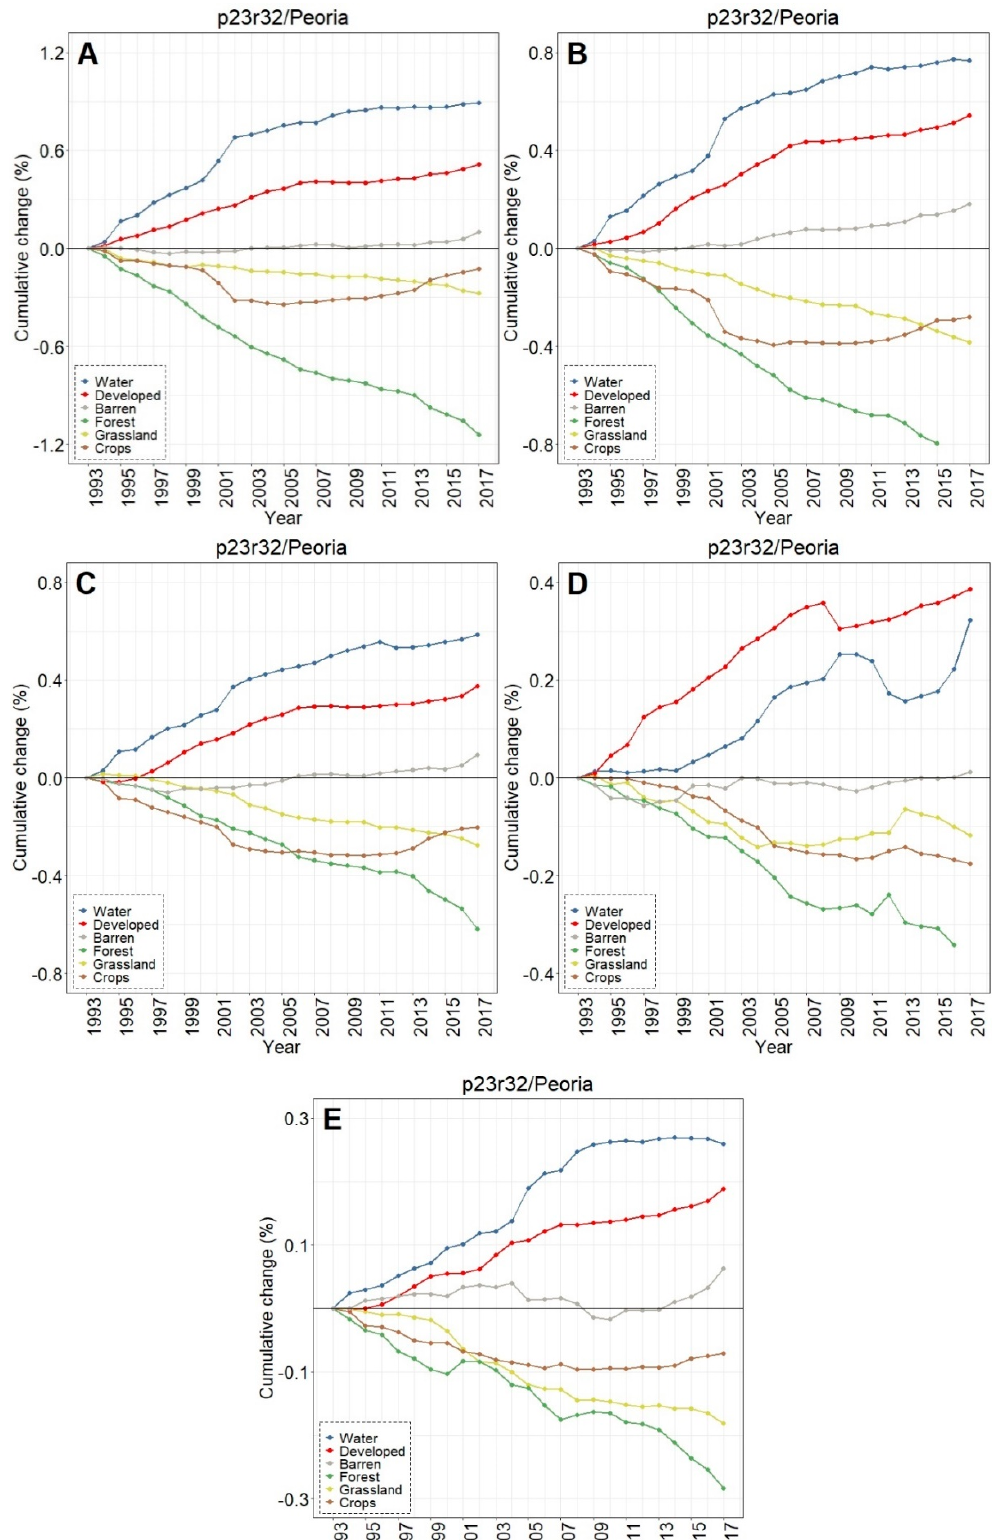
Figure 14. Peoria footprint LULC change over time in surface-water buffers binned into five aquatic system size, ( A ) < 0.1 ha, ( B ) 0.1 to < 1.0 ha, ( C ) 1.0 to < 10.0 ha, ( D ) 10.0 to < 100.0 ha, ( E ) ≥ 100.0 ha. Note the differences in the Y-values between plots.